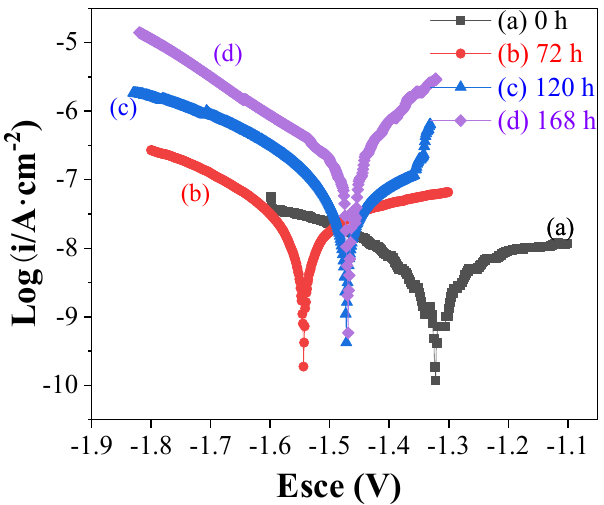
Figure 13. The contact angle after salt spray experiment of superhydrophobic coating.